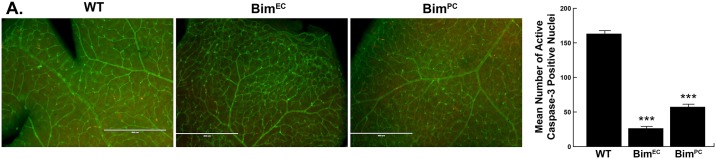
Decreased apoptosis in retinas from conditional Bim mice.Retinas from P14 wild-type, BimEC and BimPC mice were wholemount stained with anti-cleaved caspase 3 (red) and co-stained with Isolectin-B4-FITC (green). The intermediate layer was imaged and the number of cleaved caspase 3 positive cells were quantified. The data in each bar are the mean number of cleaved caspase 3 positive cells counted in the vasculature of each retina. (n = 6, ***P<0.001) The scale bar equals 400 μm.